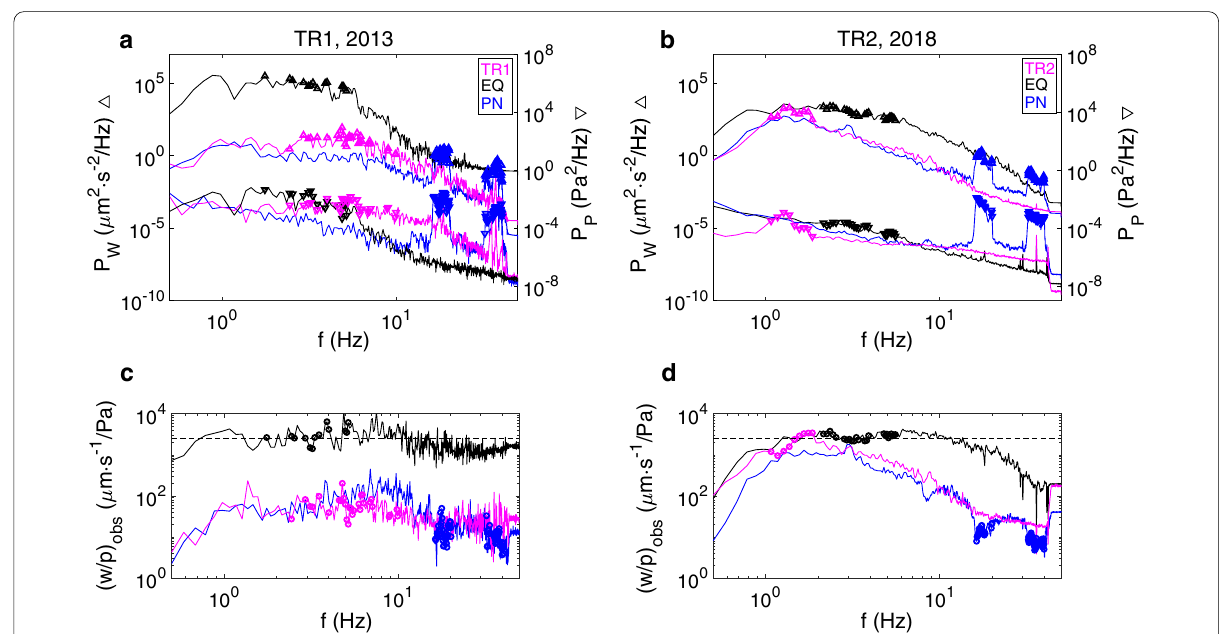
Fig. 6 The same plots of tremors (magenta) as in Fig. 3, compared with the corresponding values of EQ (black) and PN